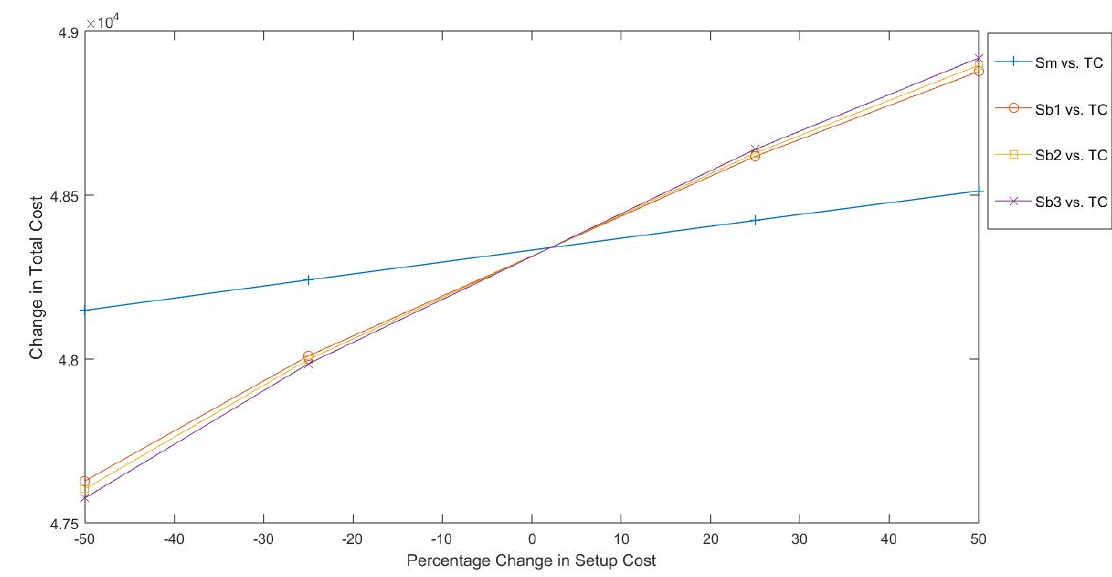
25 of 28 Appendix C Figure A1. Sensitivity analysis graph for production rate and total cost.